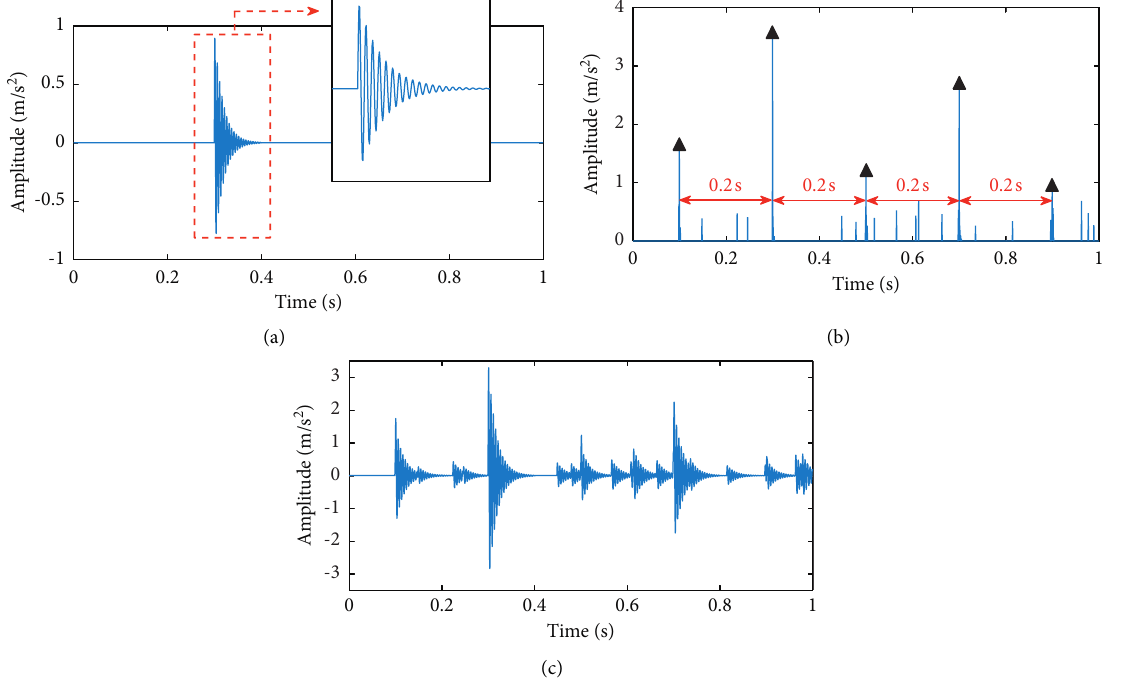
Figure 4: Results of sparse representation. (a) The optimal Laplace wavelet atom. (b) Sparse representation coefficient. (c) The reconstructed signal.